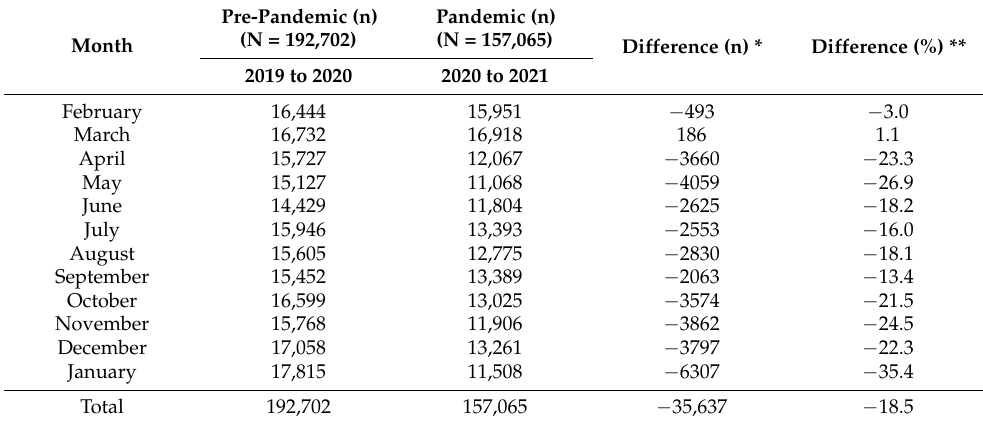
Table 1. The number of antibiotic prescriptions issued on a monthly